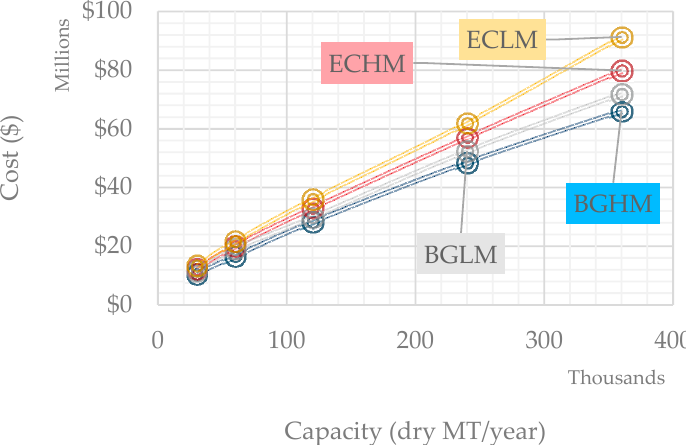
Figure 8. Uncertainty analyses of various scenarios under different capacities between 30,000 dry MT/year and 360,000 dry MT/year.